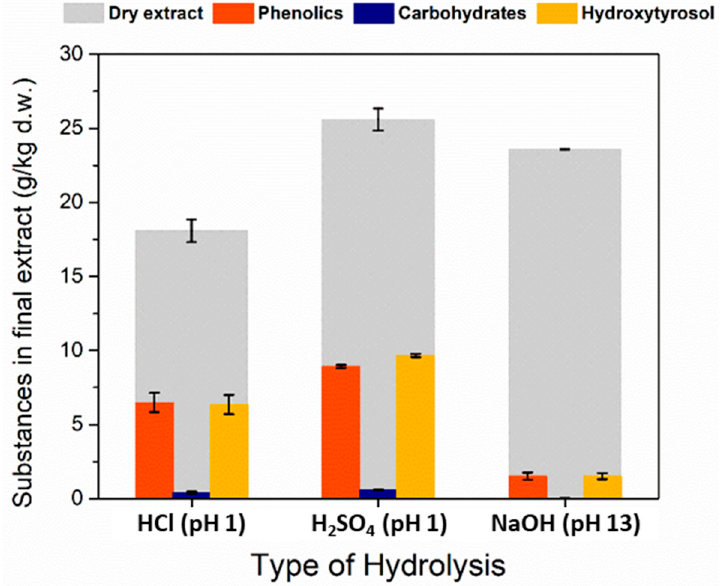
Figure 6. Effect of different catalysts for the hydrolysis of oleuropein. The quantities of substances are measured in the final extract that is claimed after liquid–liquid extraction and evaporation of ethyl acetate. Time of hydrolysis was 15 min.